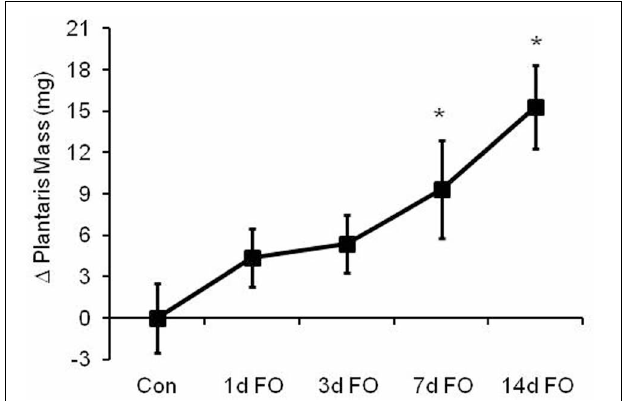
FIGURE 1 | Time course of load-induced growth in wild type (WT) mice following functional overload (FO). Growth of the plantaris muscle was calculated after 1, 3, 7, and 14 days of FO and expressed as a change in mass relative to the control group. Data are expressed as mean ± SD ( n = 8/group). ∗ P < 0 . 05 vs. control.